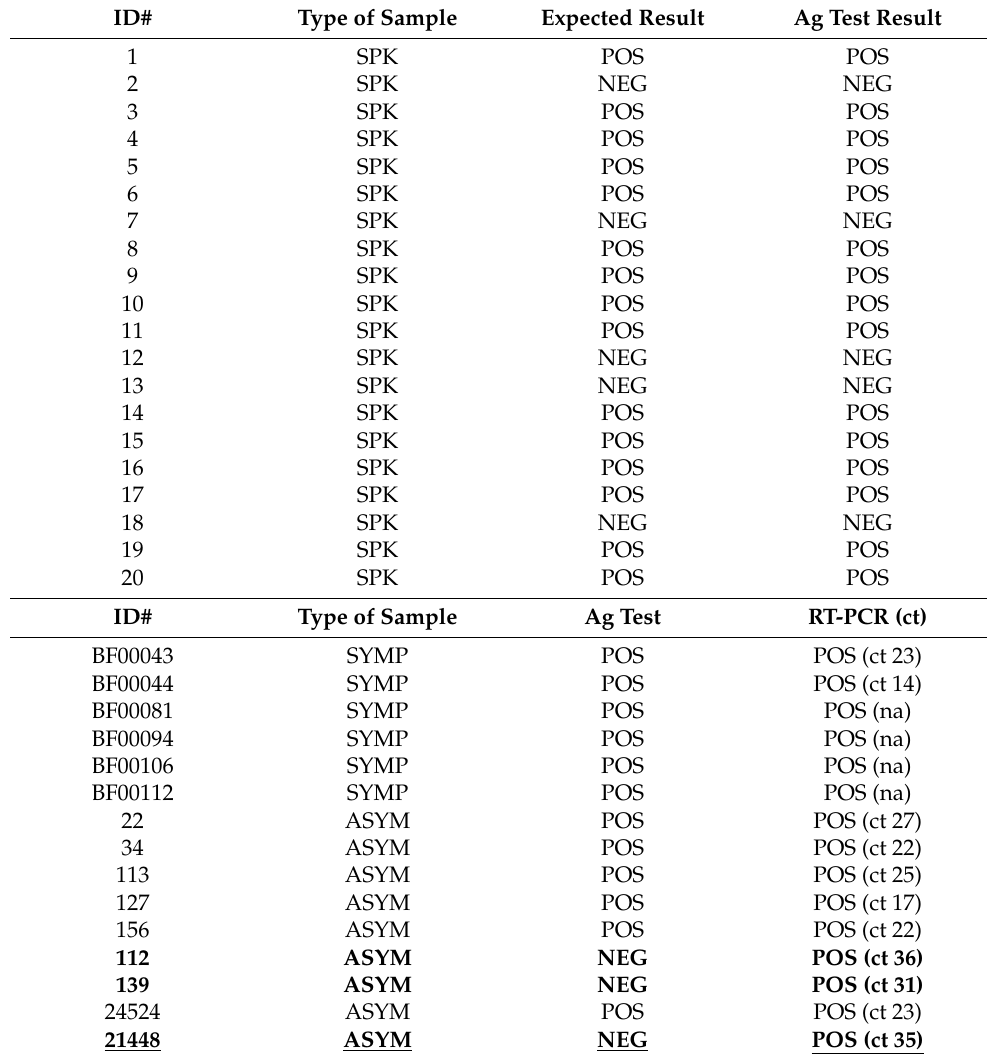
Table 1. Validation of the SARS-CoV-2 rapid antigen